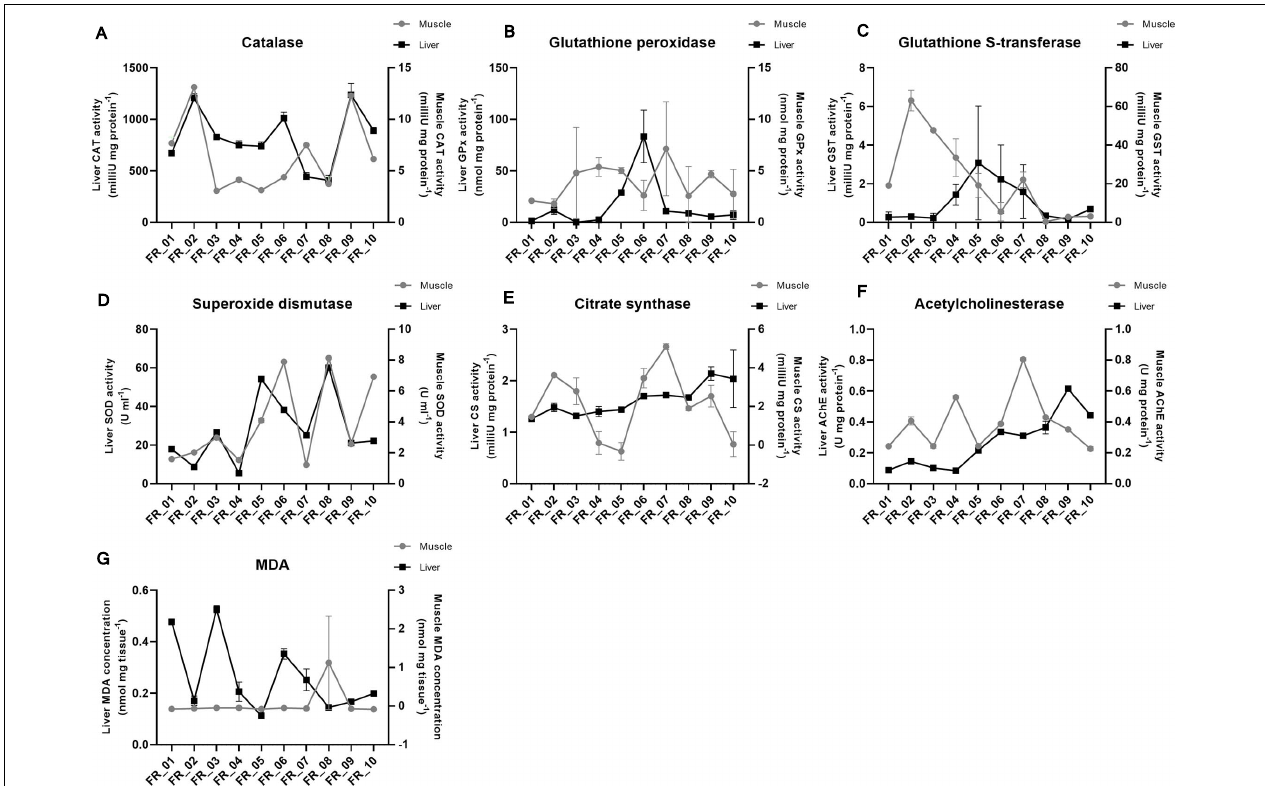
FIGURE 5 | Fish physiological responses. Catalase (A) , glutathione peroxidase (B) , glutathione S -transferase (C) , superoxide dismutase (D) , citrate synthase (E) , acetylcholinesterase (F) , and malondialdehyde (G) . Enzyme activities are expressed as either mU or U. MDA is expressed as nmol. All data were normalized to tissue protein content (mg) or weight (mg) except for superoxide dismutase. Liver and muscle data are plotted on the left and right y -axis, respectively, as mean ± SEM.